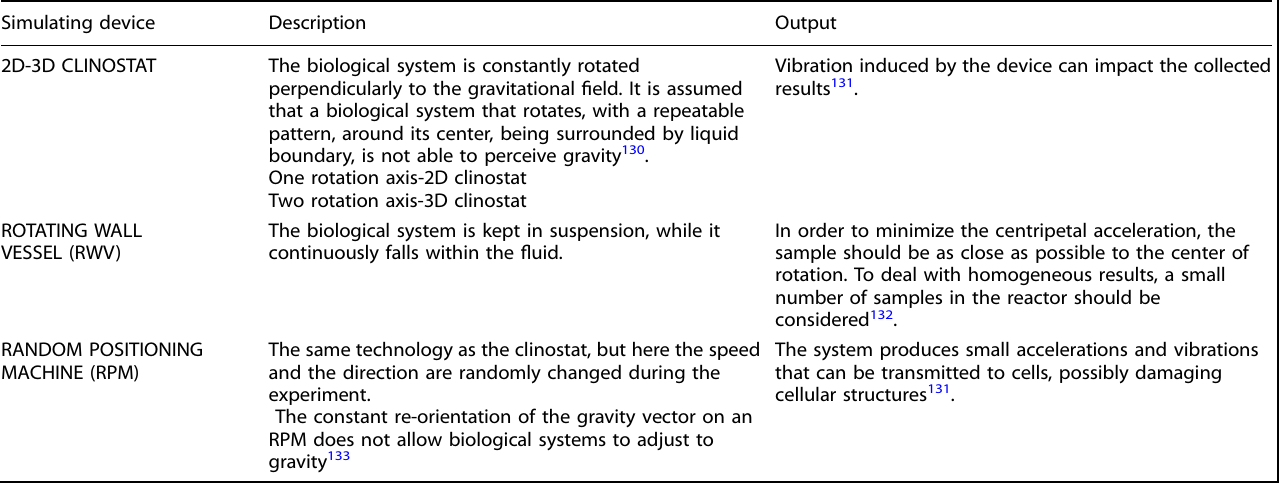
Table 3. The main experimental devices to generate simulated